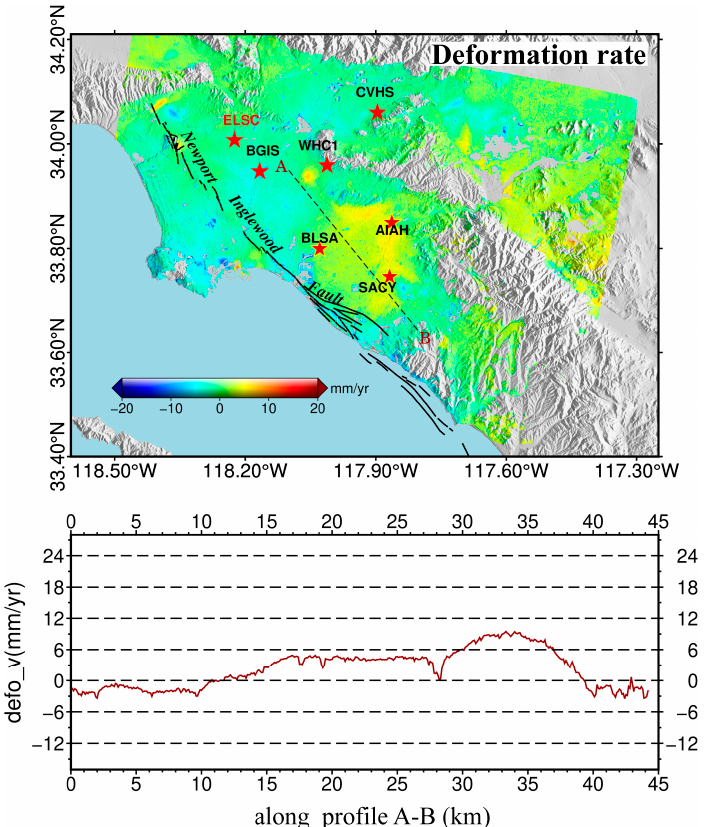
Figure 4. ( Top ) Mean LOS rate map over the Santa Ana basin from 2015 to 2018. A–B is the selected section line transecting obvious surface deformation. Red Pentagrams show the locations of the SCIGN GNSS sites for accuracy validation. ( Bottom ) Deformation rate of the observation points along the profile A–B.